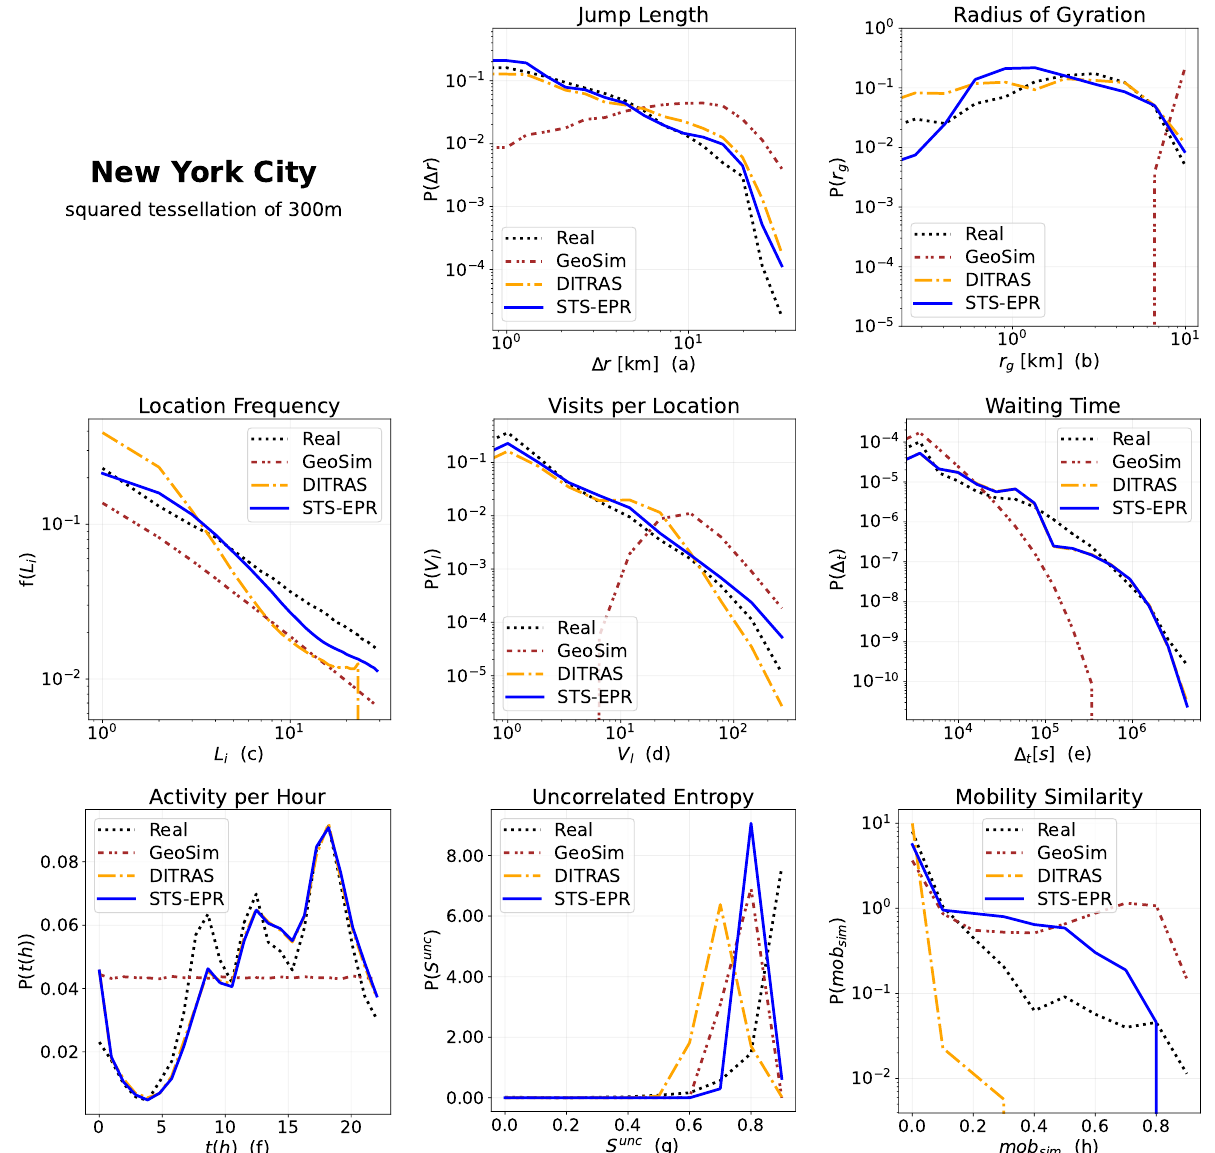
Figure 4. Comparison of the distribution of the mobility measures jump length ( a ), radius of gyration ( b ), location frequency ( c ), visits per location ( d ), waiting time ( e ), activity per hour ( f ), uncorrelated entropy ( g ), and mobility similarity ( h ) of real data (black dotted line) and data produced by GeoSim (red dash-dotted line), DITRAS (orange dash-dotted line), and STS-EPR (blue line), for New York City and the squared tessellation with tiles of 300